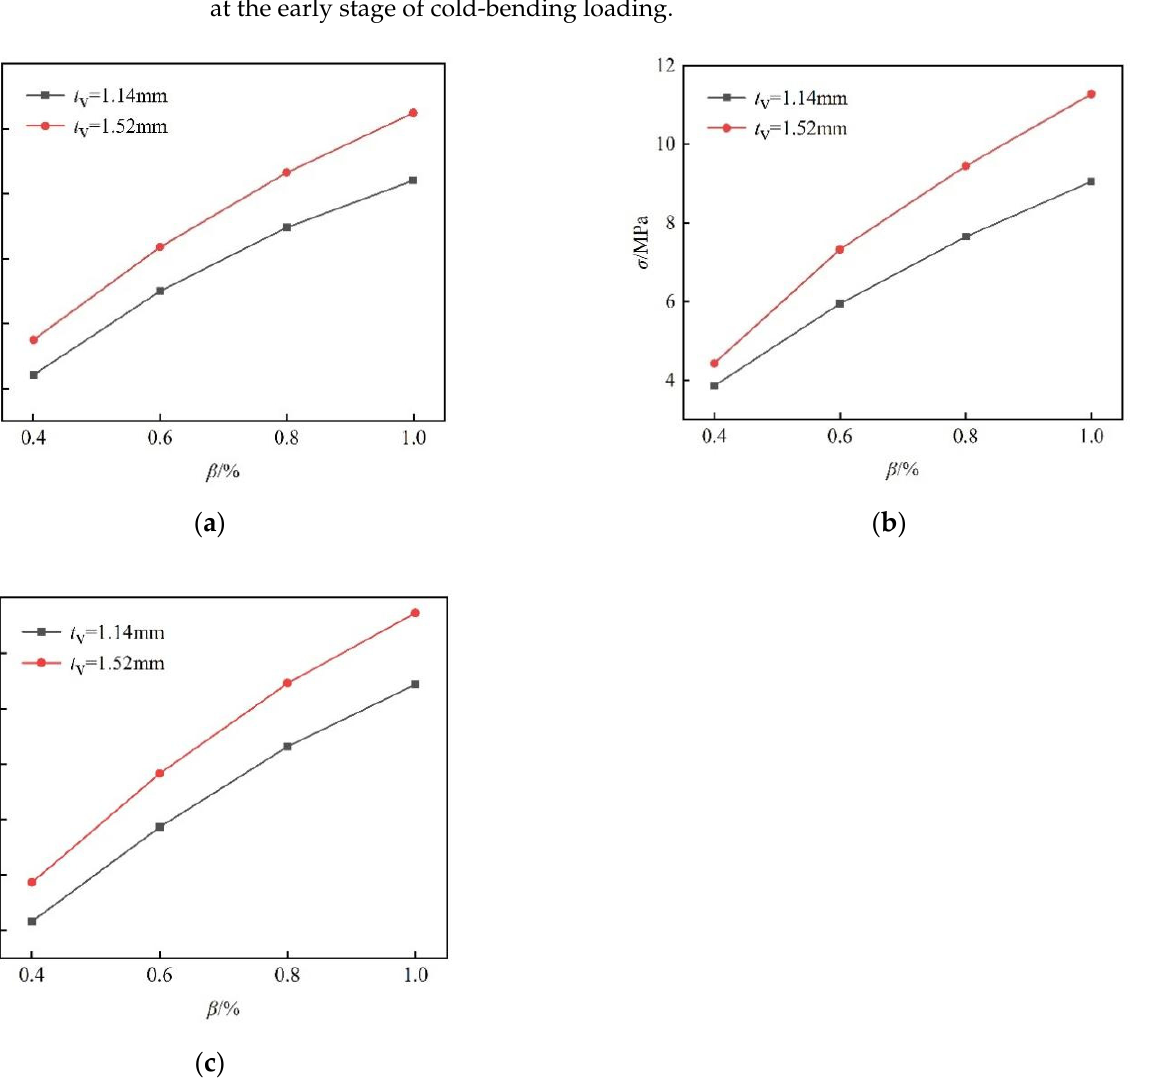
Table 2. Cold-bending stress results (MPa).